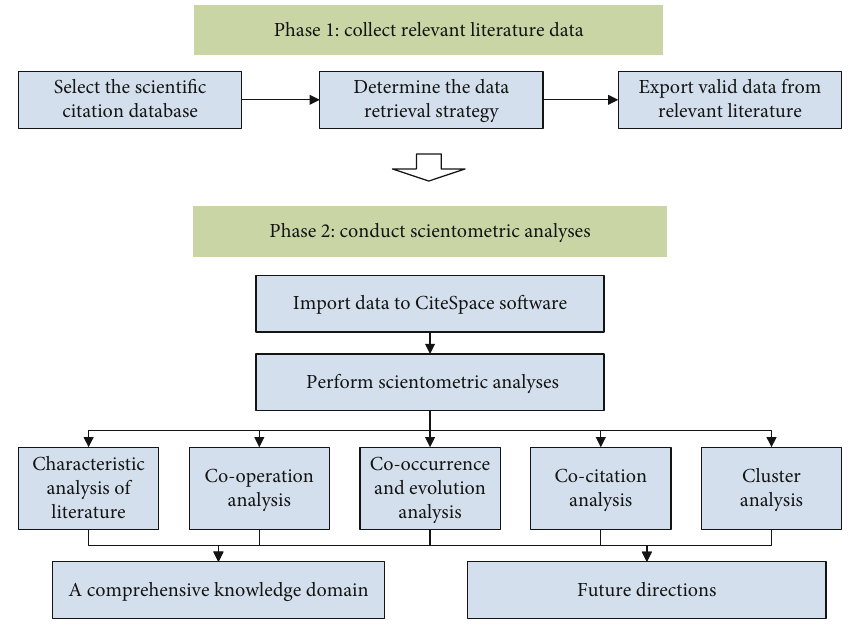
Figure 1: Frame of research methodology.